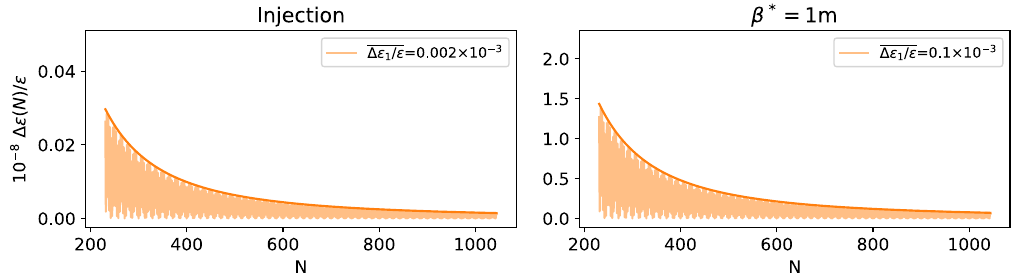
FIG. 10. Same results as in Fig. 9 but for the reaction of the regulation loop. In this case the initial Δ ϵ 1 = ϵ (average of the values in Fig. 8) is 2 . 5 × 10 − 6 for injection and 1 . 2 × 10 − 4 for β (cid:1) ¼ 1 m, factor 4 lower than for the previous effect. The larger spread of lengths causes the worst-case scenario of this effect to be about 60% of the direct effect on the magnetic flux.